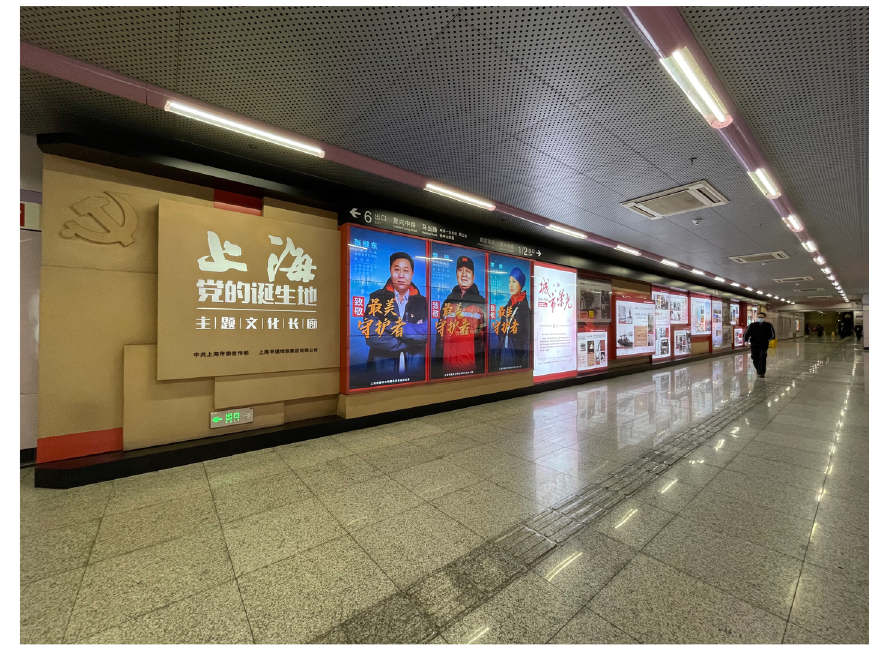
Fig. 11 Exhibition on the founding of the Communist Party of China in Xintiandi Station (lines 10 – 11). (Source: the author)